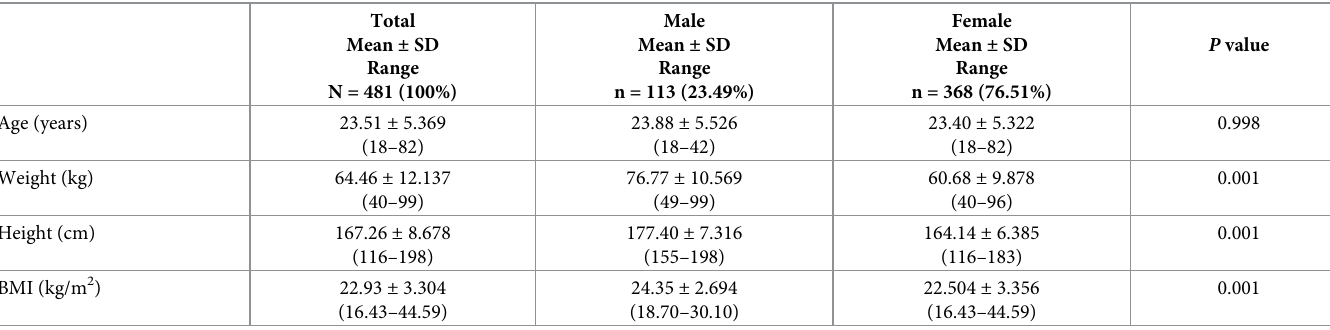
Table 1. Demographic and clinical characteristics of the sample.